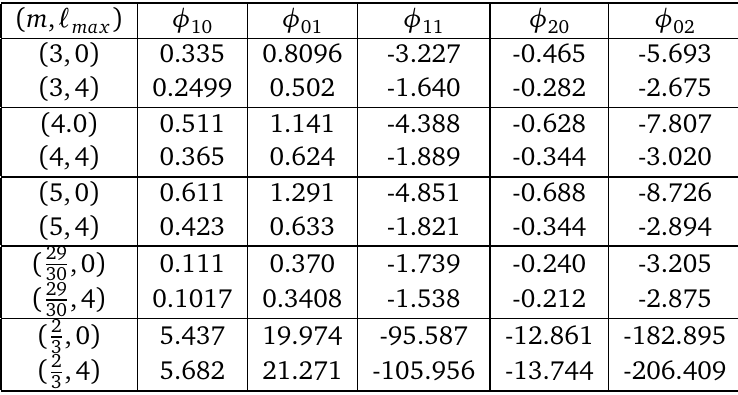
Table 1: φ using the s-channel decomposition (4.2). pq